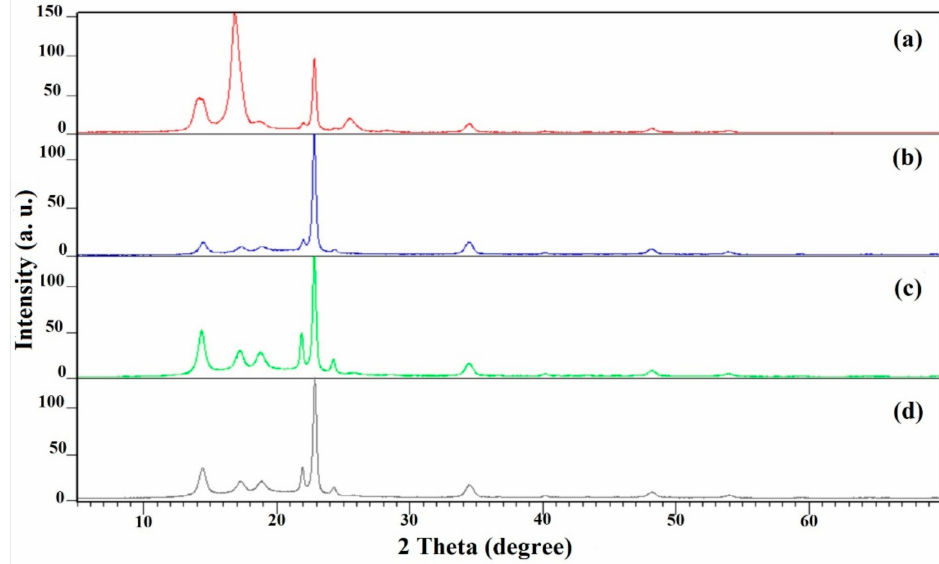
Figure 5. XRD diffractograms of the stripped and non-stripped membranes. ( a ) ESPA non-stripped, ( b ) ESPA + NaOH, ( c ) KMnO 4 and ( d ) ESPA + KMnO 4 /NaOH.